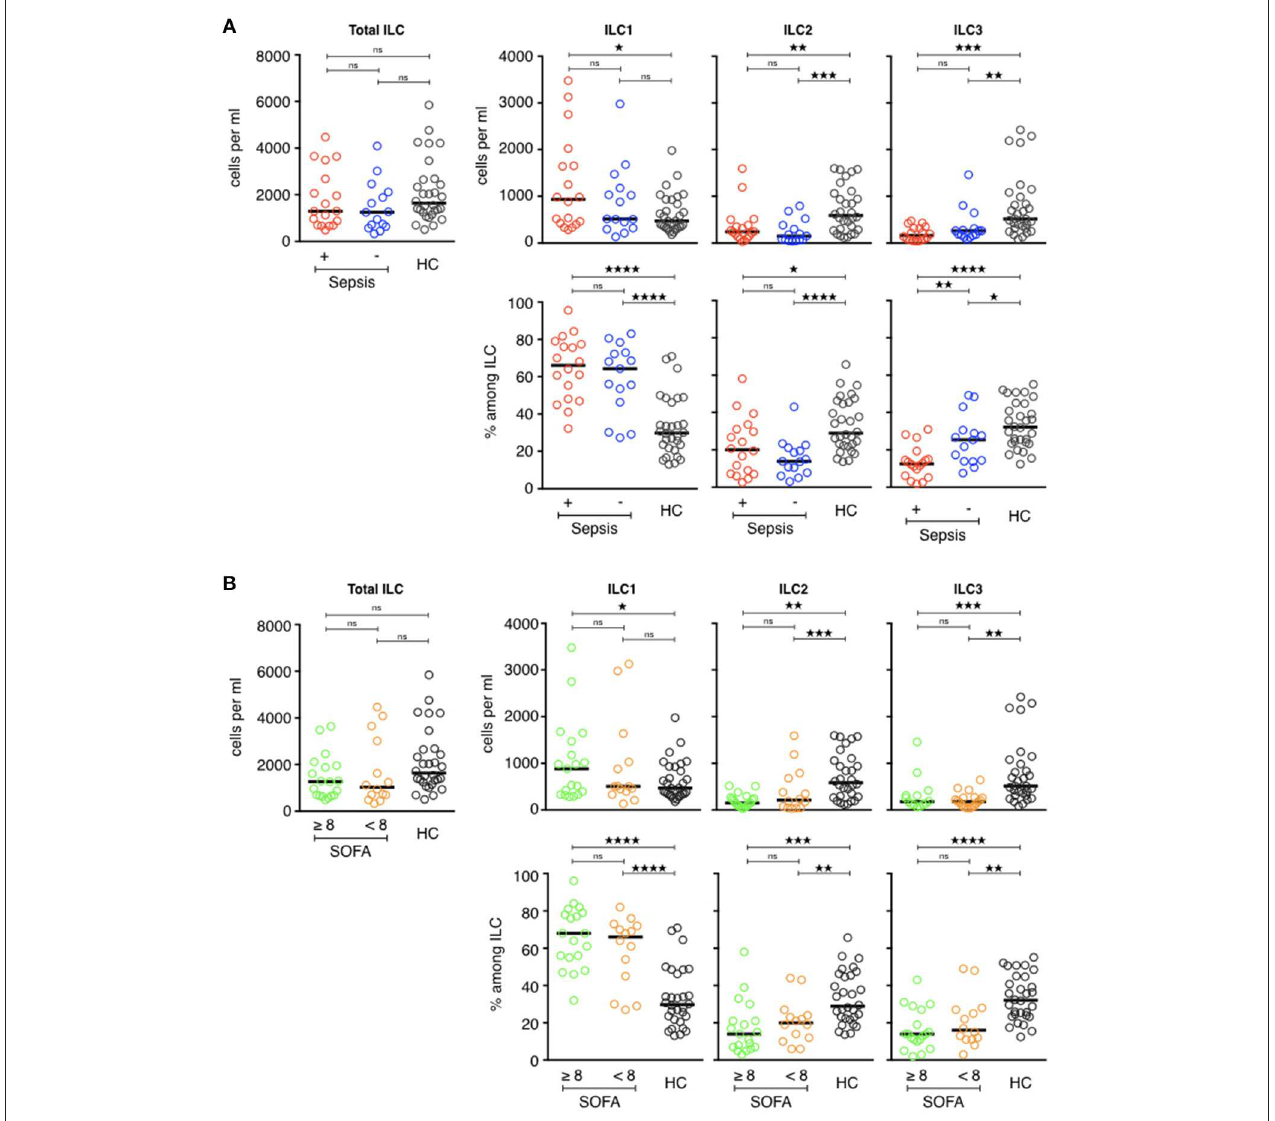
FIGURE 4 | Phenotypic analysis of circulating ILCs in ICU patients. ( A , upper) Comparison of total ILC, ILC1, ILC2, and ILC3 counts (cells/ml) of septic patients (red circles) with those of healthy controls (dark circles) and ICU patients without sepsis (blue circles). ( A , lower) Distribution of each ILC subset among total ILCs. ( B , upper) Comparison of total ILC, ILC1, ILC2, and ILC3 counts (cells/ml) of patients with severe tissue injuries (green circles) with those of healthy controls (dark circles) and patients with less severe lesions (orange circles). ( B , lower) Distribution of each ILC subset among total ILCs. The bars show the median. Statistical analyses were performed using the Mann Whitney U -test. Differences were considered significant when P < 0.05: * P < 0.05, ** P < 0.01, *** P < 0.001, **** P < 0.0001. ns: not